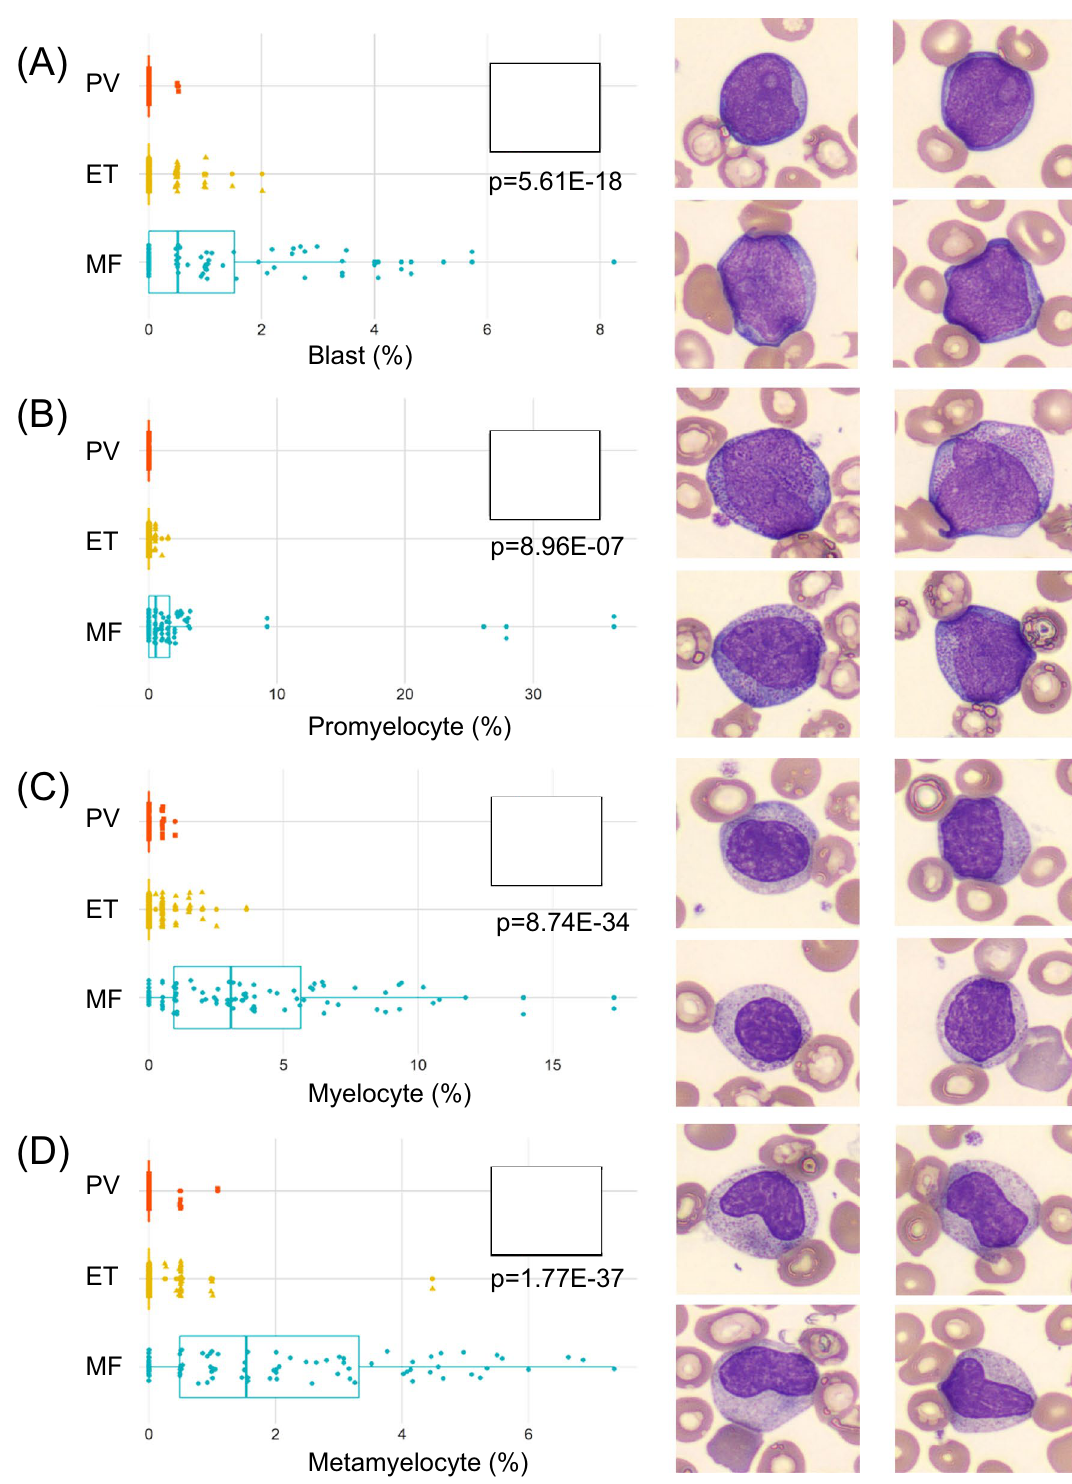
Figure 1. CNN-based morphological DLS parameters in differentiating Ph-negative MPNs. ( A - I ) The box plots (left panels) represent the percentage of cell counts for every 200 leukocytes classified by the DLS for each case of PV, ET, and MF. The right-hand side panels show representative cell images for each cell